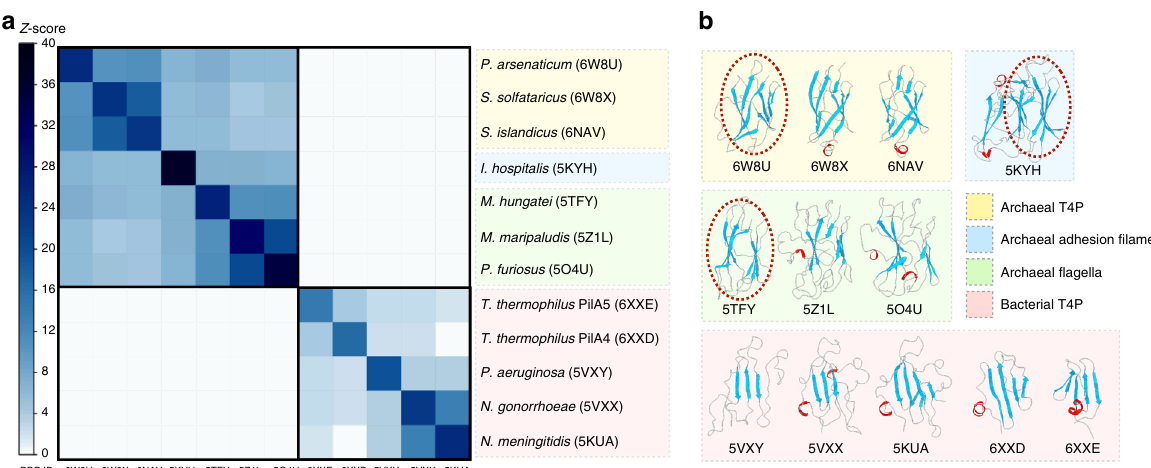
Fig. 5 Conservation and divergence of the C-terminal globular domains. a All-against-all comparison of the bacterial T4P and other archaeal structures with N-terminal T4P domains. The N-terminal helices have been removed and only the globular domains were analyzed. The matrix is based on the pairwise Z -score comparisons calculated using the DALI server 32 . The color scale indicates the corresponding Z -scores. Based on their functions and origins, the proteins are partitioned into four groups, which are indicated with different colors on the right. One representative globular domain within each archaeal group was highlighted by a red dashed circle, to show the corresponding homology region. b Ribbon diagrams of the globular domains used in a